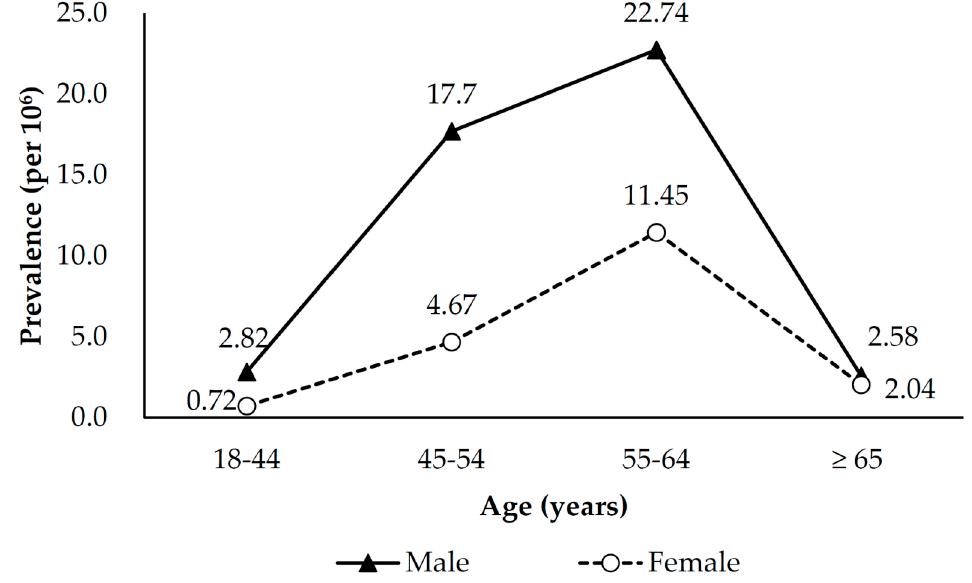
Figure 2. Sex ‐ age ‐ specific biennial prevalence of liver transplantation in Taiwan, 2000–2013.